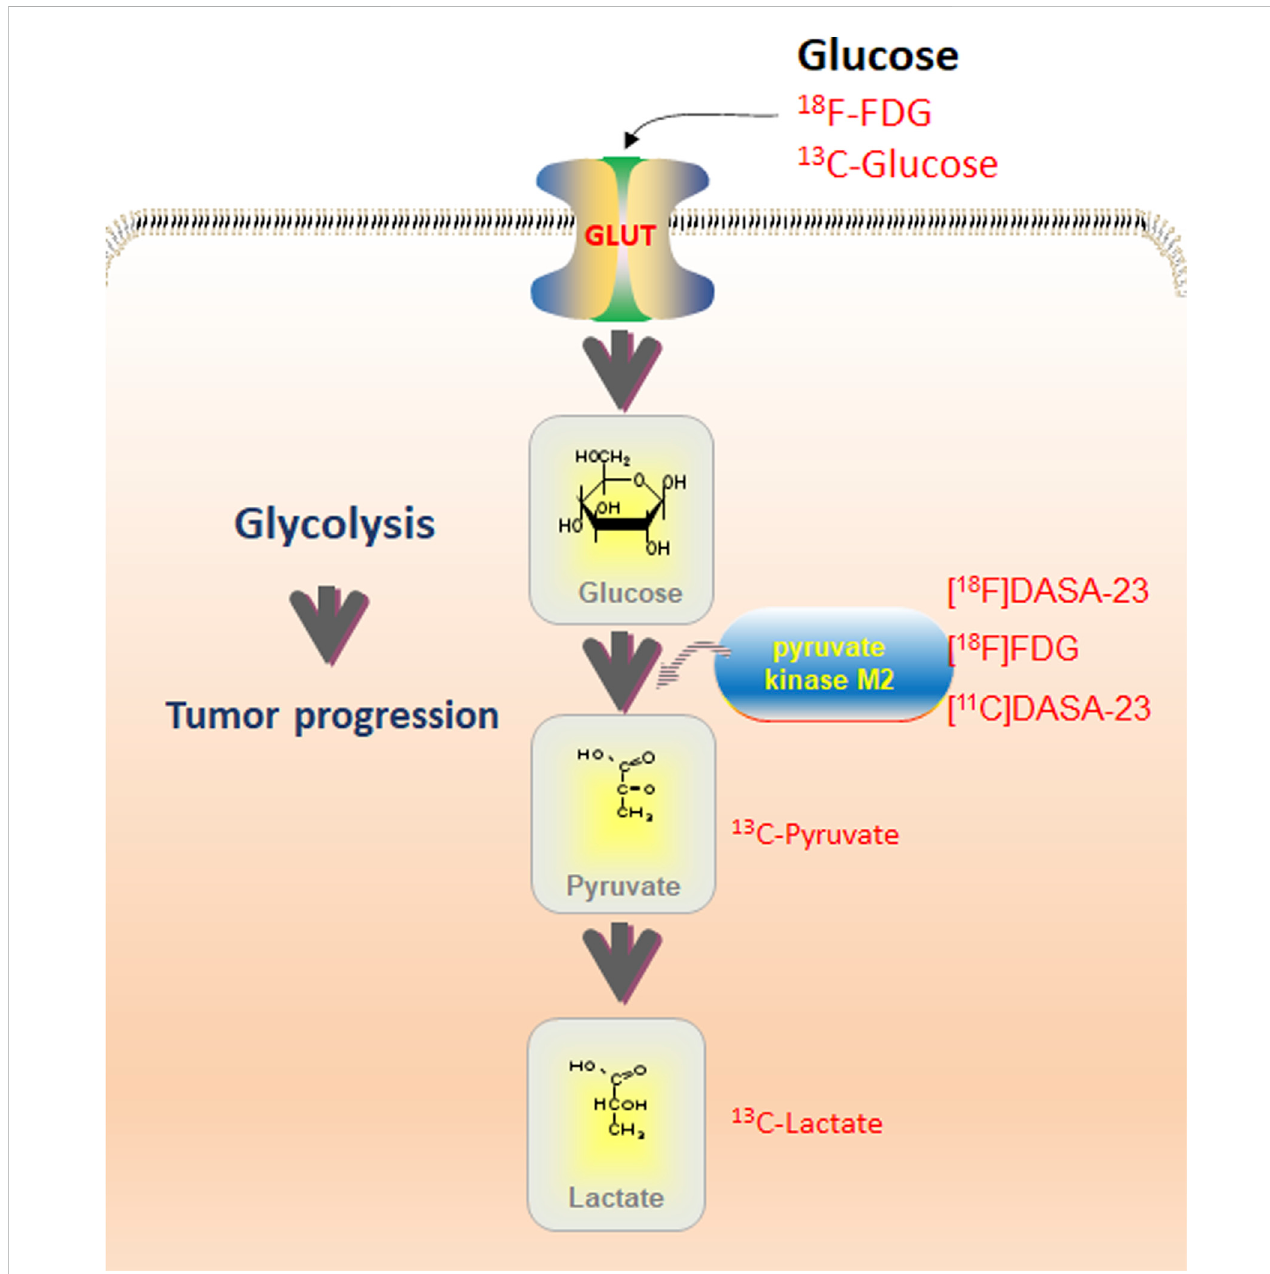
FIGURE 2 Overview of glycolysis routes detectable with various imaging techniques. PET with 18 F-FDG may detect glucose uptake; MRS with 13 C-Glucose can be used for optical imaging. Pyruvate kinase M2 (PKM2) is detectable with PET utilizing [ 18 F]DASA-23, [ 18 F]FDG, and [ 11 C]DASA-23. Contribution of pyruvate and lactate may beassessedusing 13 C-Pyruvateand 13 C-Lactateutilizing MRS. Combining imaging modalities with quantitative immunohistochemistry allows the assessment of total protein levels and